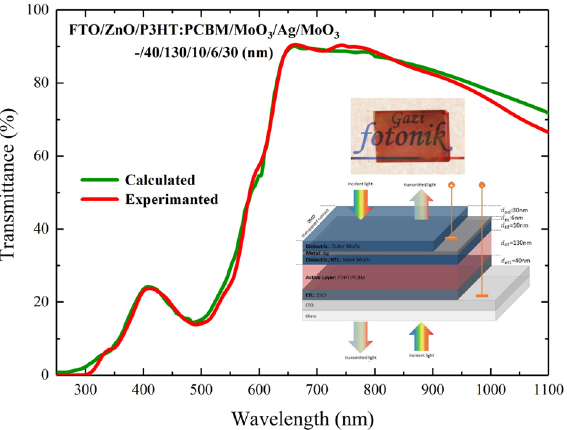
Figure 11. Calculated and experimental transmittance spectra of FTO/ZnO/P3HT:PCBM/MoO 3 /Ag/MoO 3 (–/40/130/10/6/30 nm) ST-OSC.